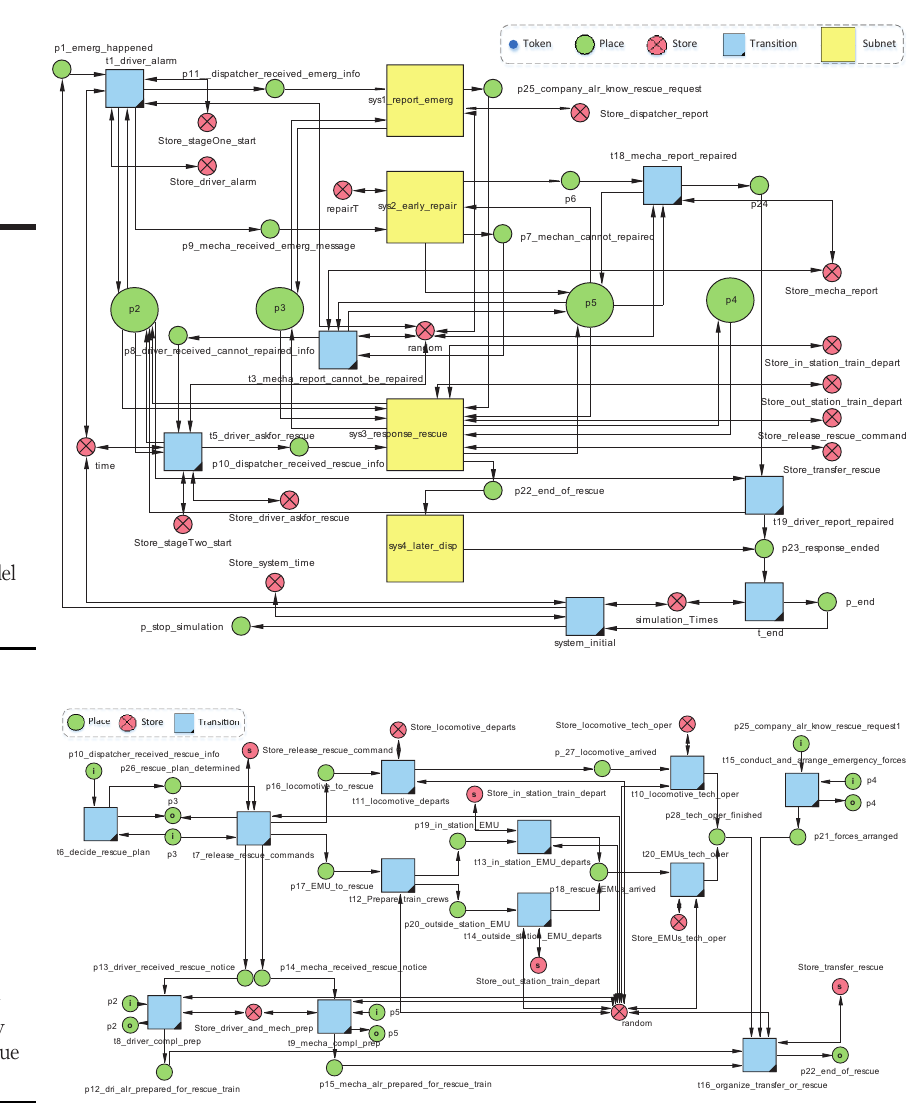
The simulation time of the HTPN model of EMUs rescue emergency plan is as shown in Figure 9 . In Figure 9, T_transfer , T_stage1 , T_stage2 and T_total refer to the simulation duration of t ( t16_organize_transfer_or_rescue ), the fi rst stage of early alarming, the second stage 16 of emergency response and rescue and the total time of the complete process, respectively. According to the simulation results, the total time is prone to lead to an emergency response